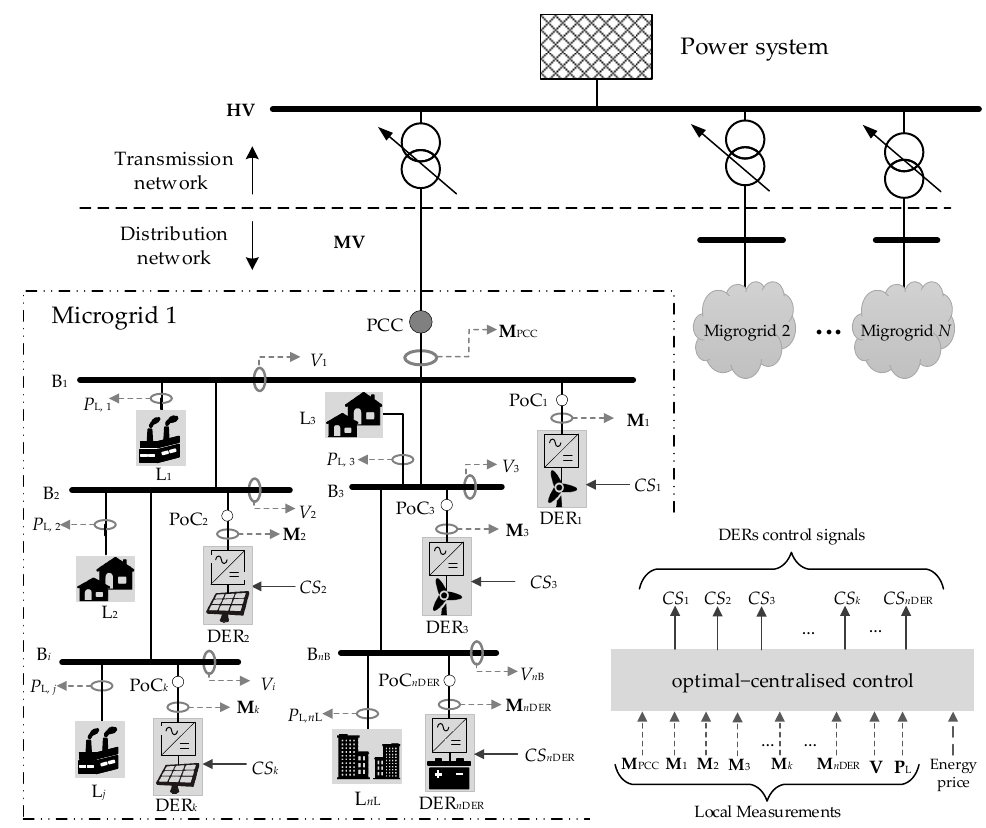
Figure 3. Illustrative scheme of the proposed optimal microgrid-interactive reactive management indicating the inputs and outputs of the optimal-centralised control.